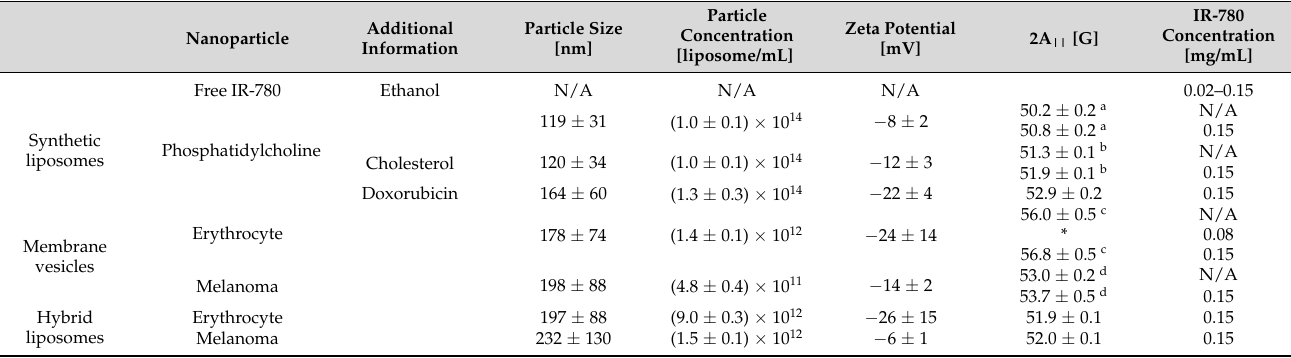
Figure 1. Schematic figure showing the five types of nanoparticles investigated, namely, synthetic liposomes (SLs); cell-membrane-based nanostructures, erythrocyte (ELs) and melanoma B16F10 vesicles (MLs); and hybrid liposomes formed from the fusion of synthetic lipids and cell membranes, hybrid erythrocyte liposomes (HELs) and hybrid melanoma liposomes (HMLs). Table 1. Physical characteristics of the